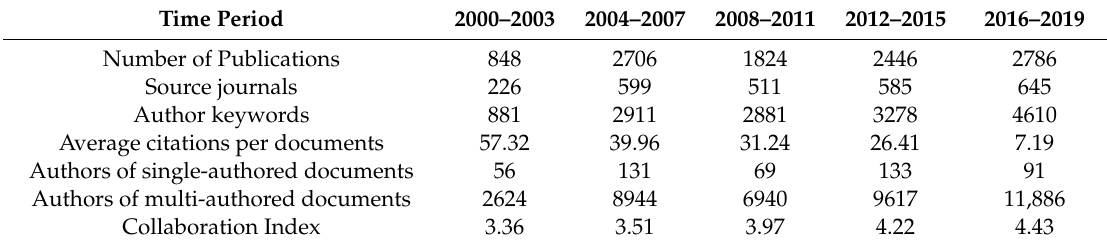
Table 1. Main information of the relevant coronavirus publications between the year of 2000 and